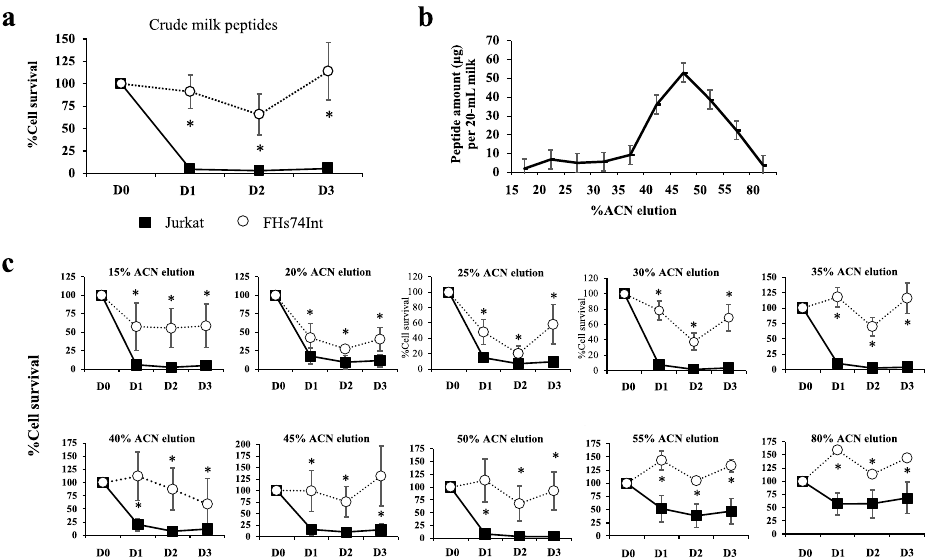
Figure 2. Fractionation of peptides from human milk and cytotoxicity of fractions towards leukemic and normal cells. Ten samples of human milk were divided into 3 pools. Twenty milliliters of each pool were centrifuged at 4 °C to remove cells, lipid, and extracellular vesicles. The crude milk peptides obtained from each pool were separately eluted through a cut-off column of <3 kDa, and the eluate was loaded to a C18 SPE column. Milk peptides bound to the C18 SPE column were eluted with various concentrations of acetonitrile (ACN) from 15% ACN to 80% ACN (1 mL each). Eluted fractions of milk peptides were dried using a SpeedVac concentrator, resuspended in a culture medium and then used to treat Jurkat (black square) and FHs74Int cells (white circle), using 3 biological replicates. WST-1 assay was applied to measure cell viability. ( a ) % cell survival (mean ± SEM) after the treatment of cells with crude milk peptides for 1 (D1), 2 (D2), or 3 (D3) days, compared to those of the untreated control (D0); ( b ) amounts of peptides eluted from the C18 SPE column eluted in a stepwise manner using 1 mL each of increasing ACN concentrations of 15%, 20%, 25%, 30%, 35%, 40%, 45%, 50%, 55%, and 80% ACN. Peptides were quantitated by the Bradford method and shown as mean ± SEM; ( c ) % cell survival (mean ± SEM) after the treatment of cells with eluates obtained at different %ACN concentration, for 1 day (D1), 2 days (D2), or 3 (D3) days, compared to those of the untreated controls (D0). * p < 0.05 comparing to the untreated condition.